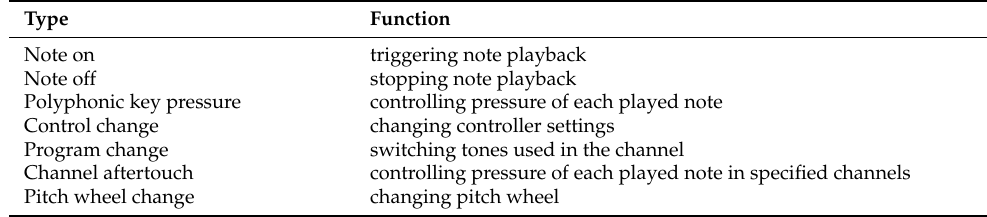
Table 1. MIDI event